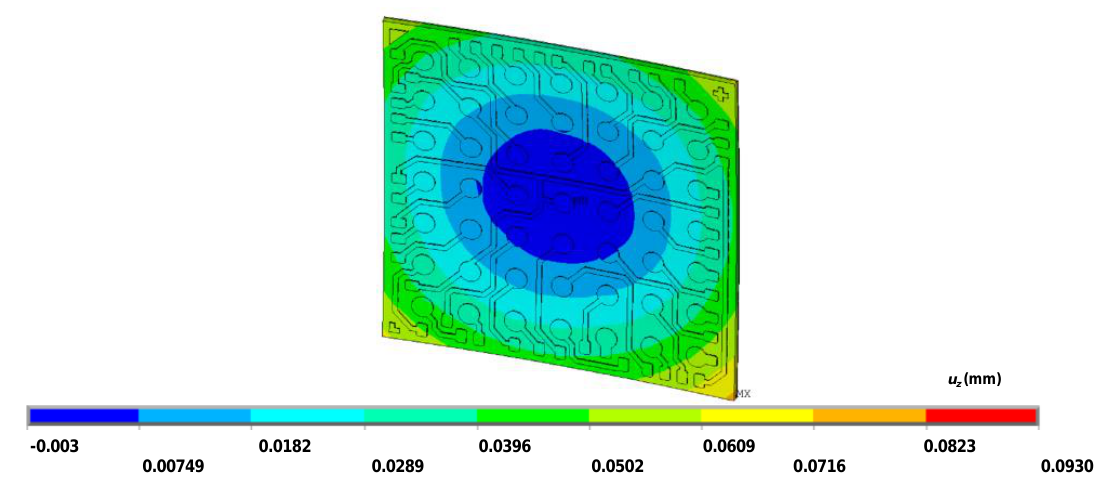
Figure 6. The simulated result with the full dummy pattern.